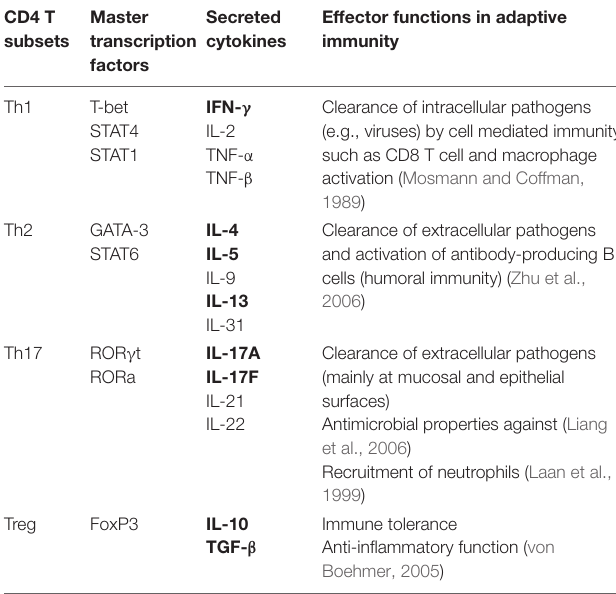
TABLE 2 | CD4 T helper cell subsets, their molecular signatures, and their main effector functions in